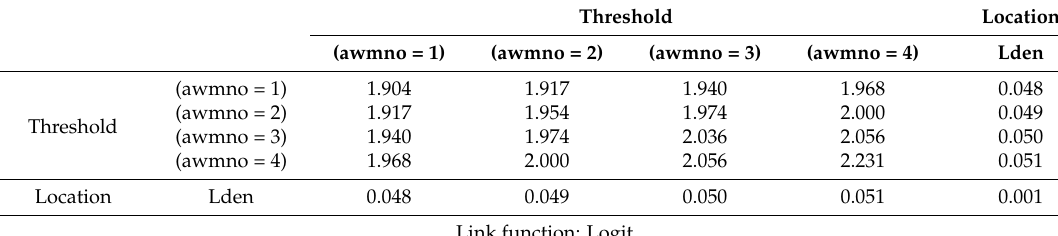
Table A1b. Estimated covariance matrix.